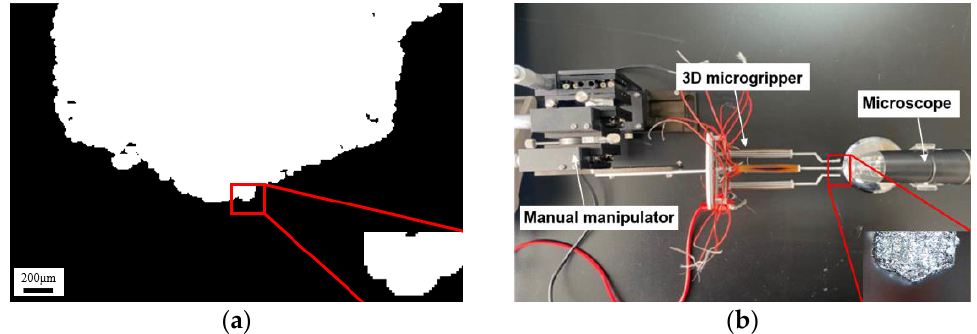
Figure 7. Template matching of the microgripper tip. ( a ) The matching template; ( b ) displacement measuring.